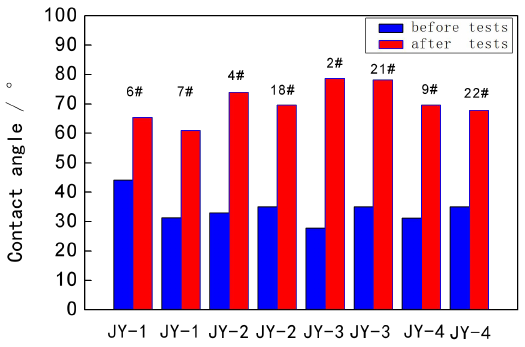
Figure 6—Wettability before and after adding